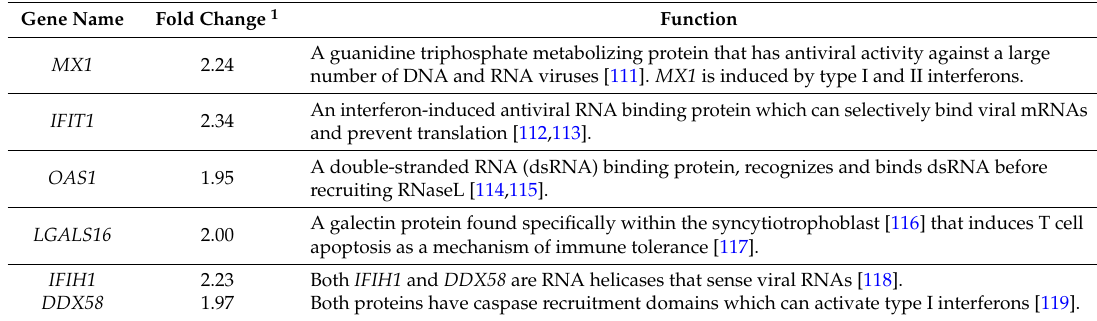
Table 2. List of viral sensing genes with altered expression following lncRHOFX1